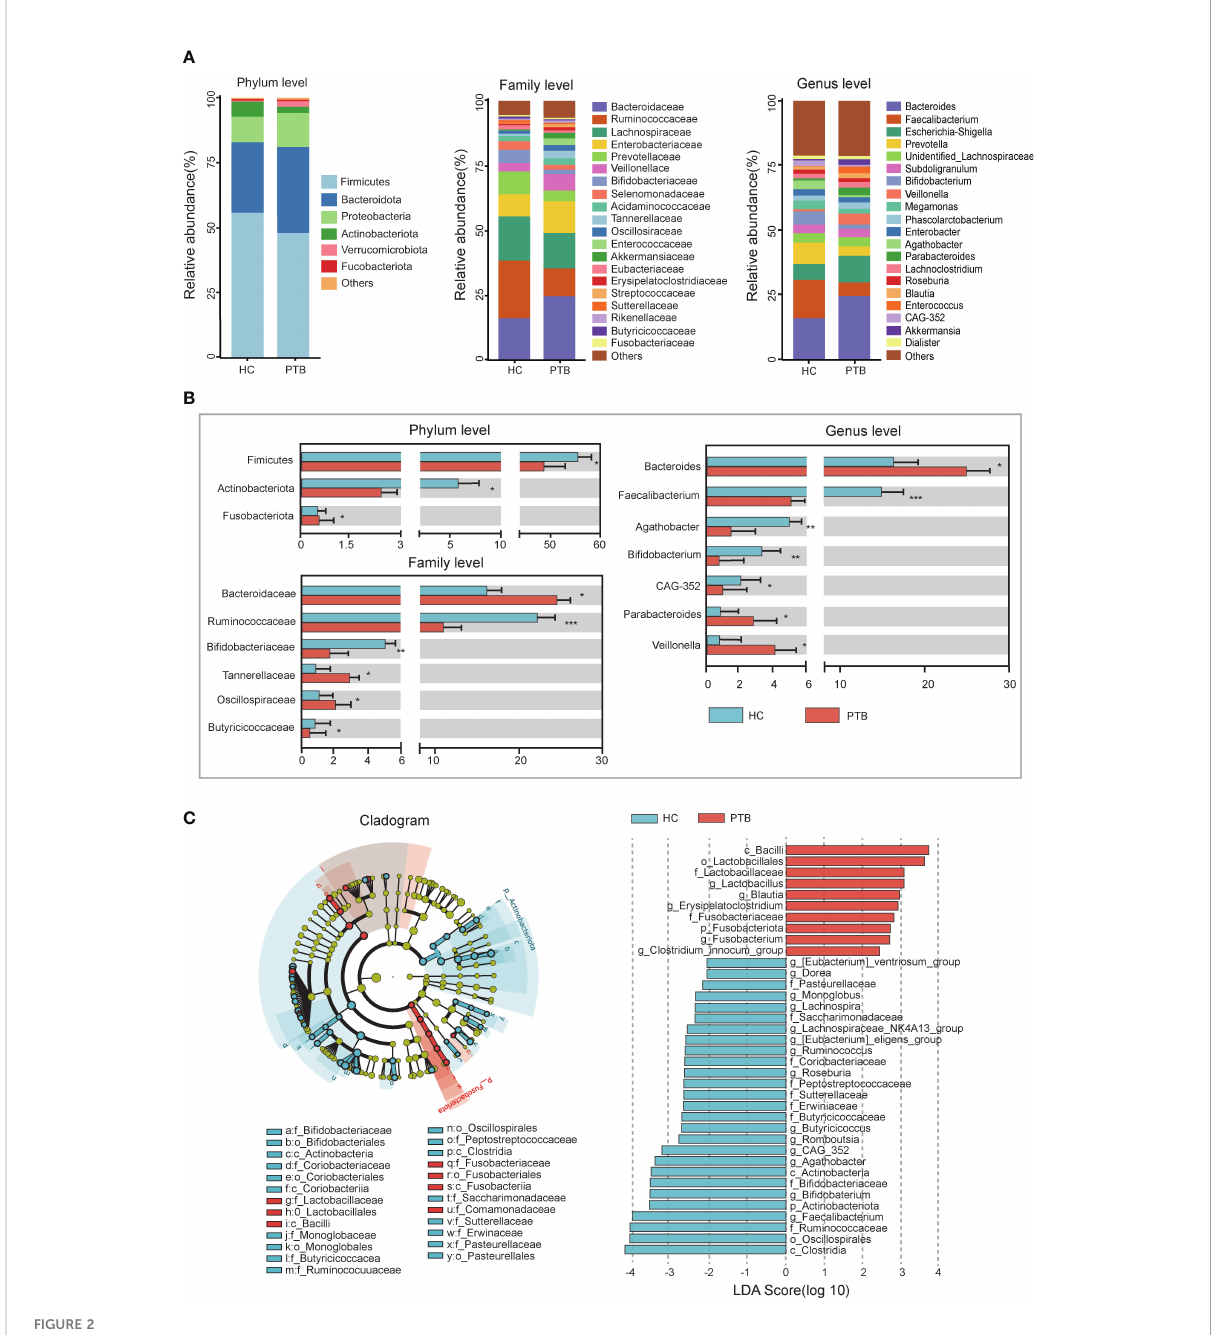
FIGURE 2 Relative abundance and LEfSe analysis of intestinal microbiota. (A) The relative abundance of intestinal fl ora between the PTB patients (red) and HCs (blue) at the phylum level, the family level and the genus level. (B) The statistical difference of intestinal fl ora between two groups. * P <0.05, ** P <0.01, *** P <0.001. The signi fi cance was assessed by Student ’ s t test. (C) The cladogram identi fi ed the differentially abundant taxa between the PTB patients and HCs. The HC-enriched taxa were indicated with a negative LDA score (blue), and the taxa enriched in the patients with PTB were characterized by a positive score